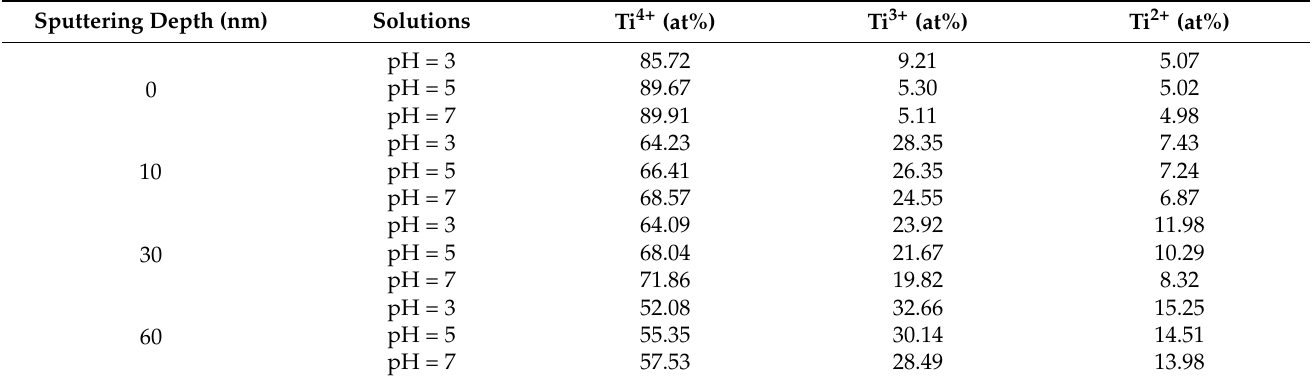
Table 3. Ratios of Ti ions with different valences in the passive films formed on the LPBFed Ti–6Al–4V at different sputtering depths, after potentiostatic polarization under 1.0 V SCE in Hank’s solution with different pH values (pH = 3, 5, and 7).